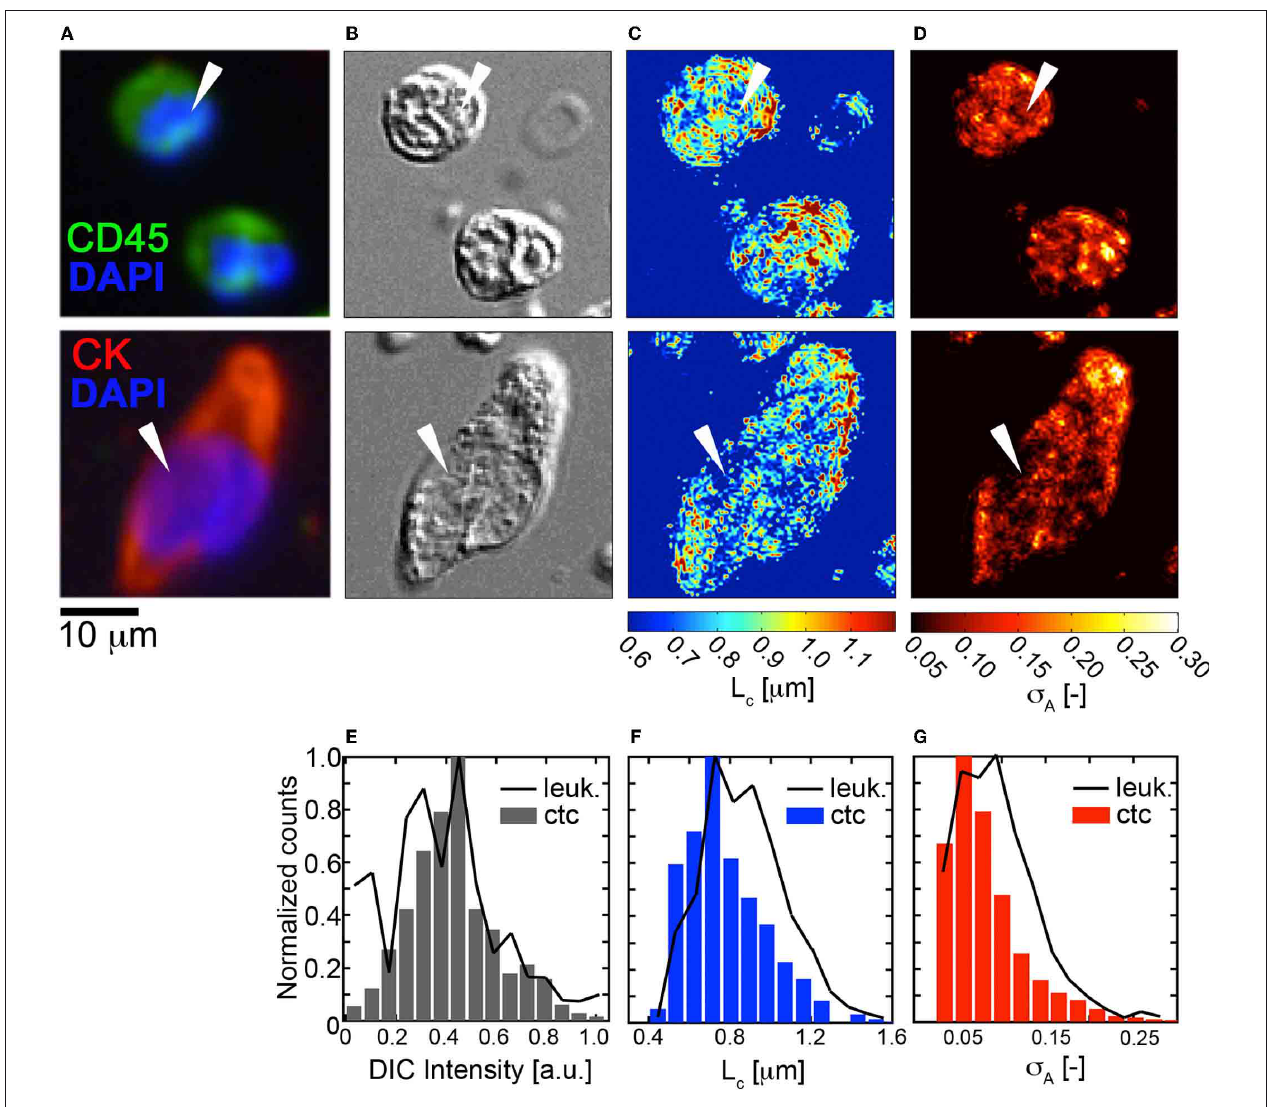
FIGURE 4 | Fluctuation and spatial correlation maps: comparison of HD-CTCs and leukocytes. (A) Merged fluorescence image of HD-CTCs and leukocytes, (B) corresponding DIC images, (C) spatial correlation length map, (D) density amplitude fluctuation map,